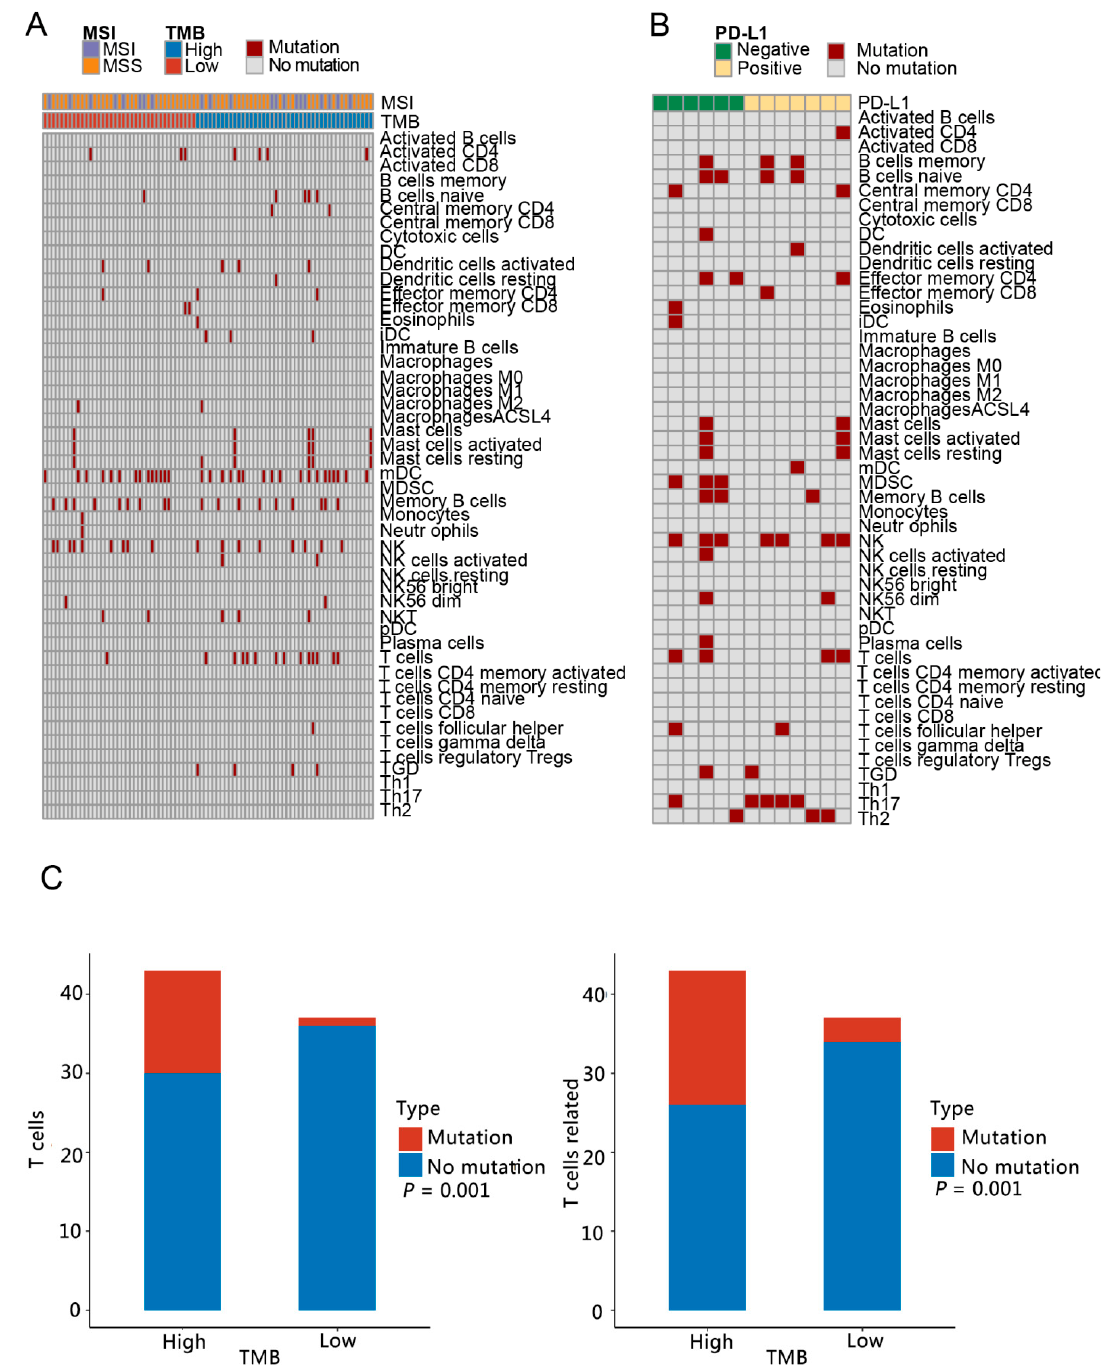
Figure 3. Types and functions of characteristics of immune cells in different groups. ( A ) Heatmap depicting immune cell type and function of all mutated genes in group 1. There were 25 kinds of immune cell type and function among these genes that were mutated in group 1. ( B ) Heatmap showing types and functions of immune cells of all mutated genes in group 2. These mutated genes were enriched in 26 categories of immune cell types and functions. ( C ) The number of people with the mutation genes related to immune cell type and function were compared between TMB-L and TMB-H, and there were 2 kinds of differential immune cell type and function between TMB-L and TMB-H groups.